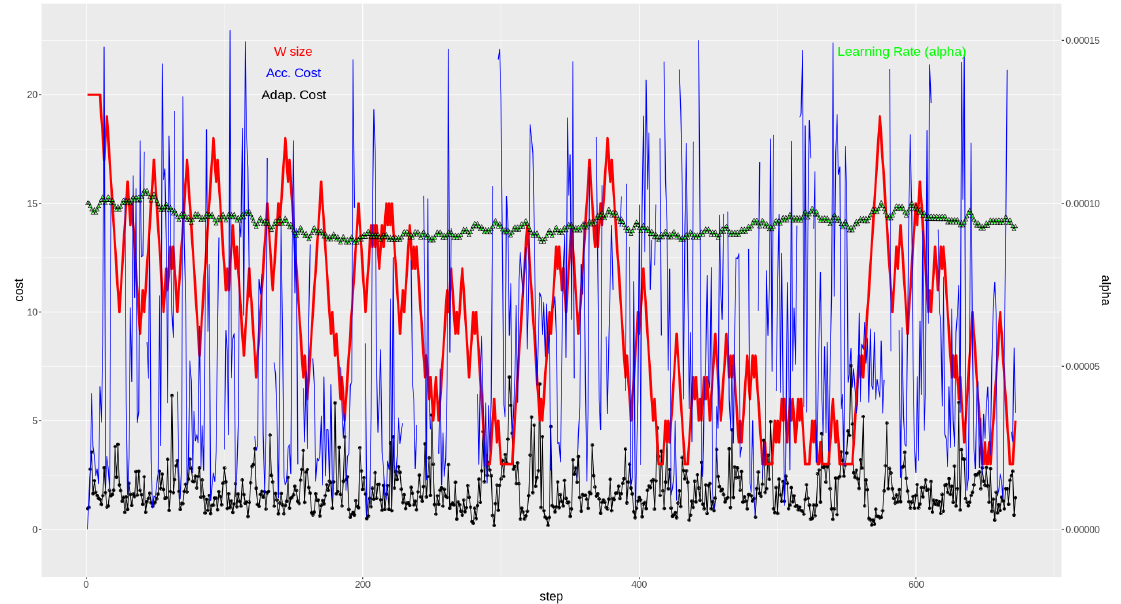
Figure 7. Weather station ID C619Y: Best performance case for the adaptive method. In the lower part, cost (MSE, (m/s) 2 ) obtained with the adaptive strategy (black) and with the accumulative strategy (blue). In the upper part, window size (red) and learning rate (green), both for the adaptive strategy.